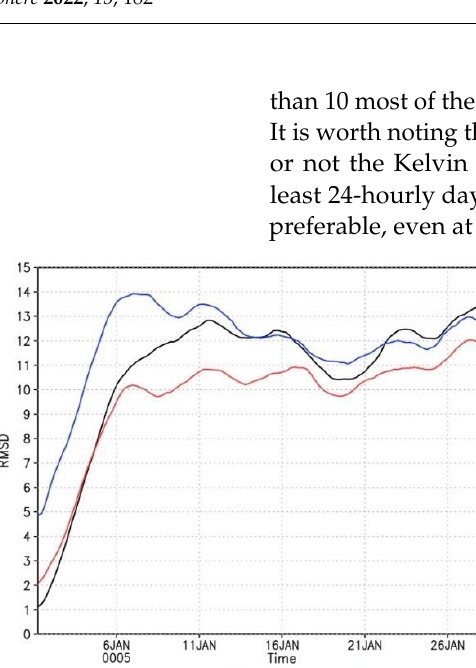
9 of 13 Figure 7. Latitude – altitude cross-sections of zonally averaged zonal wind (m/s; color) and temper- ature (K; contour) on 30 January, 5th year for the ( a ) frf and ( b ) control cases. 3.4. Requirements for Future Observations Finally, we will investigate the conditions required to reproduce the Kelvin wave using actual data assimilation from satellite studies of horizontal winds, such as the Akatsuki Venus climate orbiter. On OSSEs, two types of sensitivity checks of synthetic observations were performed. The first is dependent on the range of observation longi- tude, and the second is dependent on observation frequency. To quantify the modifica- tion, we calculate the root-mean -square deviation (RMSD), which is defined as 𝑅𝑀𝑆𝐷 = √1 𝑁 ∑(𝑋 𝑖 − 𝑥 𝑖 ) 2𝑁 𝑖=1 , (4) where 𝑋 𝑖 and 𝑥 𝑖 indicate the results of the frf and each assimilated case, respectively, and N is the total number of horizontal grids at 70 km. Figure 8 shows the time evolution of the RMSD for the sensitivity test of observation (a) longitude and (b) frequency. The dependence on the range of observation longitude is not as large in (a). If we can only observe half the zonal range compared to the control case (red line), the Kelvin wave is marginally reproduced. If the zonal range of observation